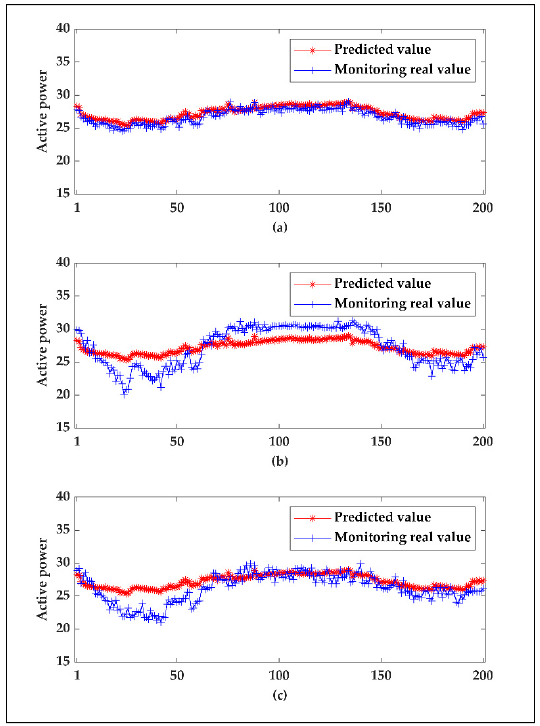
Table 5. The back propagation neural network (BPNN) model performance of different numbers of nodes in the hidden layer.